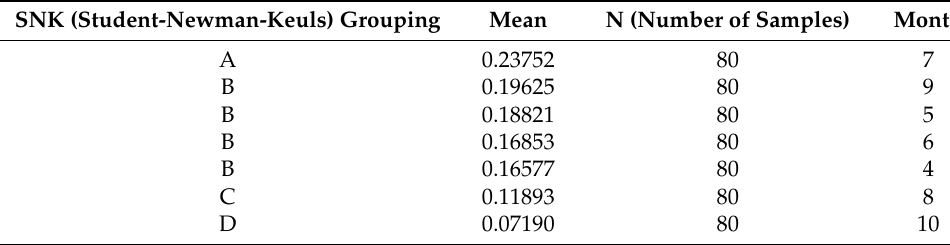
Table 5. Difference analysis in different